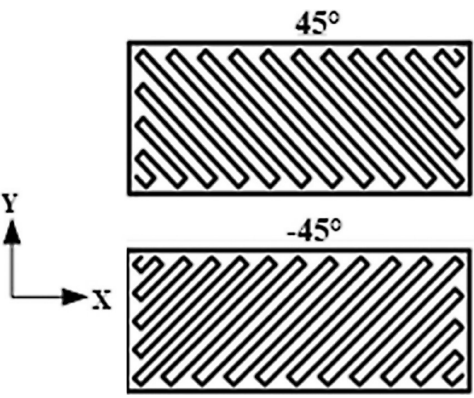
Figure 2. Layer deposition with different raster angles.